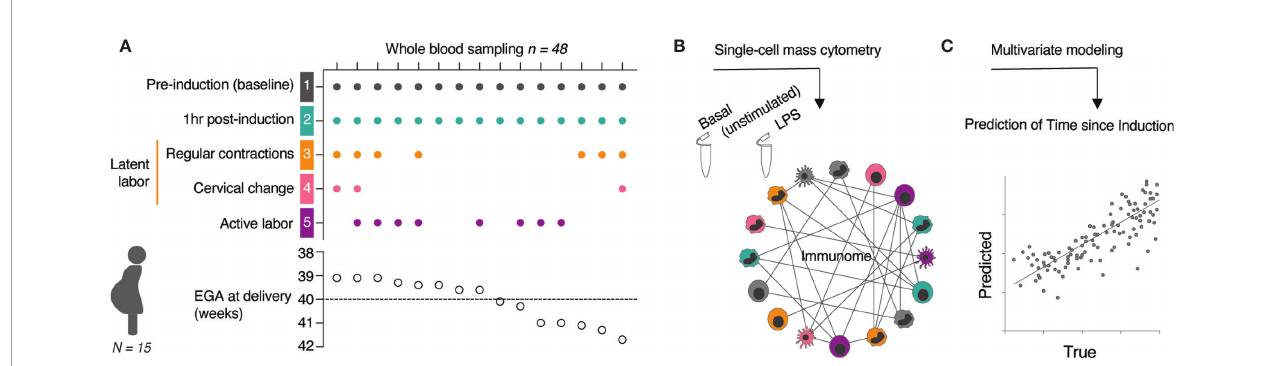
FIGURE 1 | Experimental work fl ow and analytical approach. (A) Whole blood samples were collected at indicated time points (T1 to T5) from 15 women with term pregnancies undergoing induction of labor. (B) A mass cytometry immune-assay was employed to measure the frequency, and single-cell intracellular signaling activities in all major immune cell populations at basal level (unstimulated) and after 15 min stimulation with LPS. (C) The high-dimensional data set was used in a multivariate modeling approach to predict the time since induction (TSI) from the correlation relationship between all immune features across sampling time points. See also Table 1